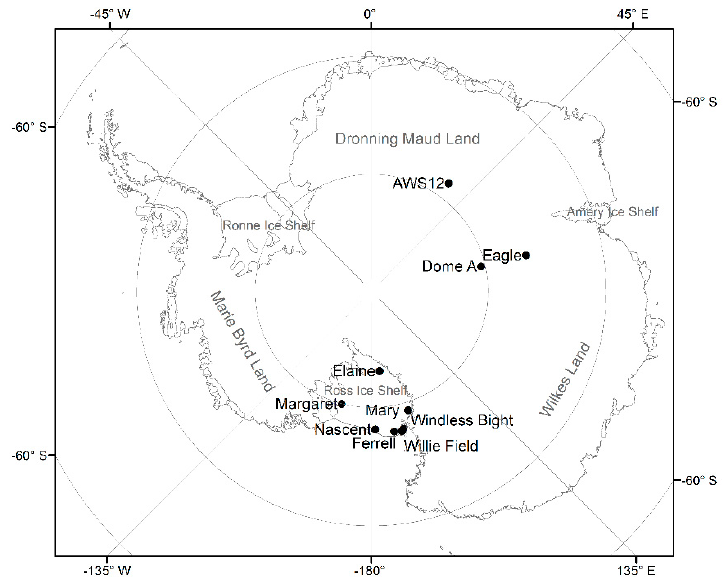
Figure 2. Map of Antarctica showing the locations of the ten automatic weather stations (AWSs). The daily snowfall rate at the AWSs marked with an asterisk in Table 1 was measured by CloudSat. The time coverage varied between stations (see Table 1). Table 1. Locations, lengths of records and elevations of the AWSs. Snow accumulations at the five stations marked with an asterisk (*) were accumulated to a daily resolution and data from the other five stations were accumulated to a two-day resolution.